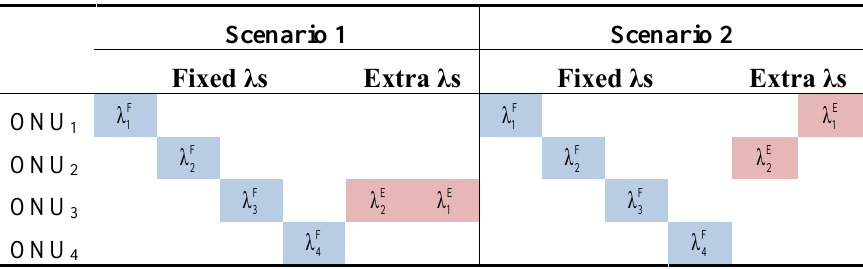
Table 1. Experimental routing scenarios.